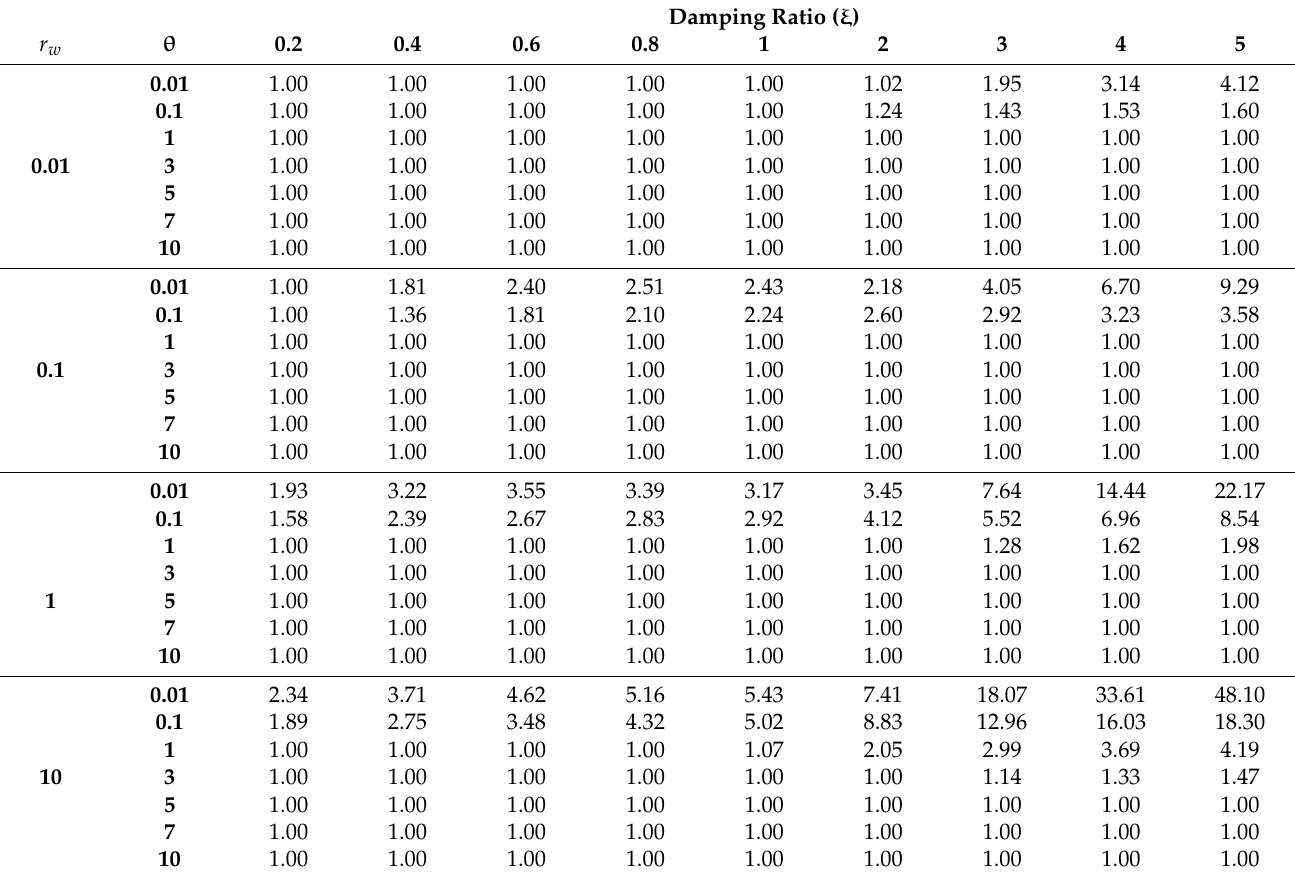
Table 5. Normalized IAE for MPC (Process 2, setpoint